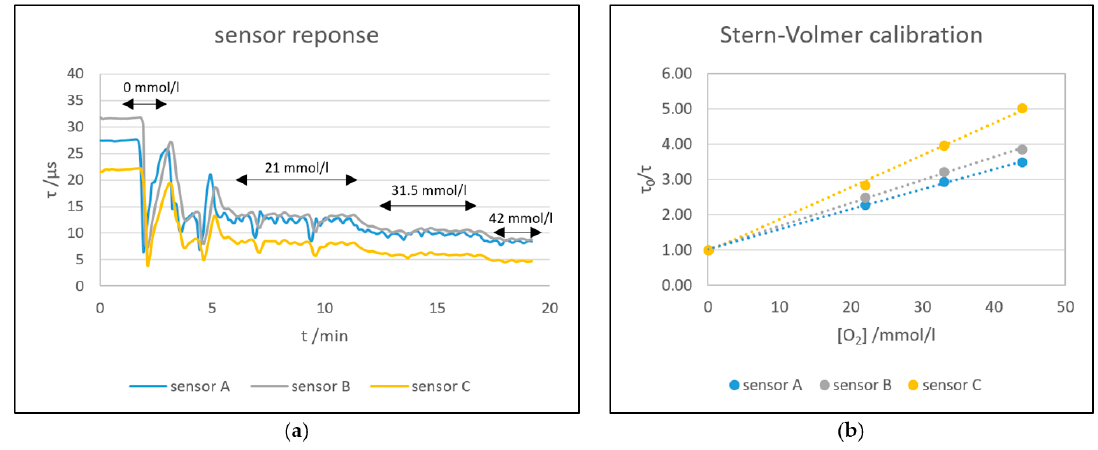
Figure 5. ( a ) recorded oxygen content during a multi-step calibration with four oxygen concentrations (0, 21, 31.5, 42 mmol/L O 2 ); ( b ) Stern-Volmer plot of all three sensors showing the linearity of the calibrations despite diverging absolute lifetime